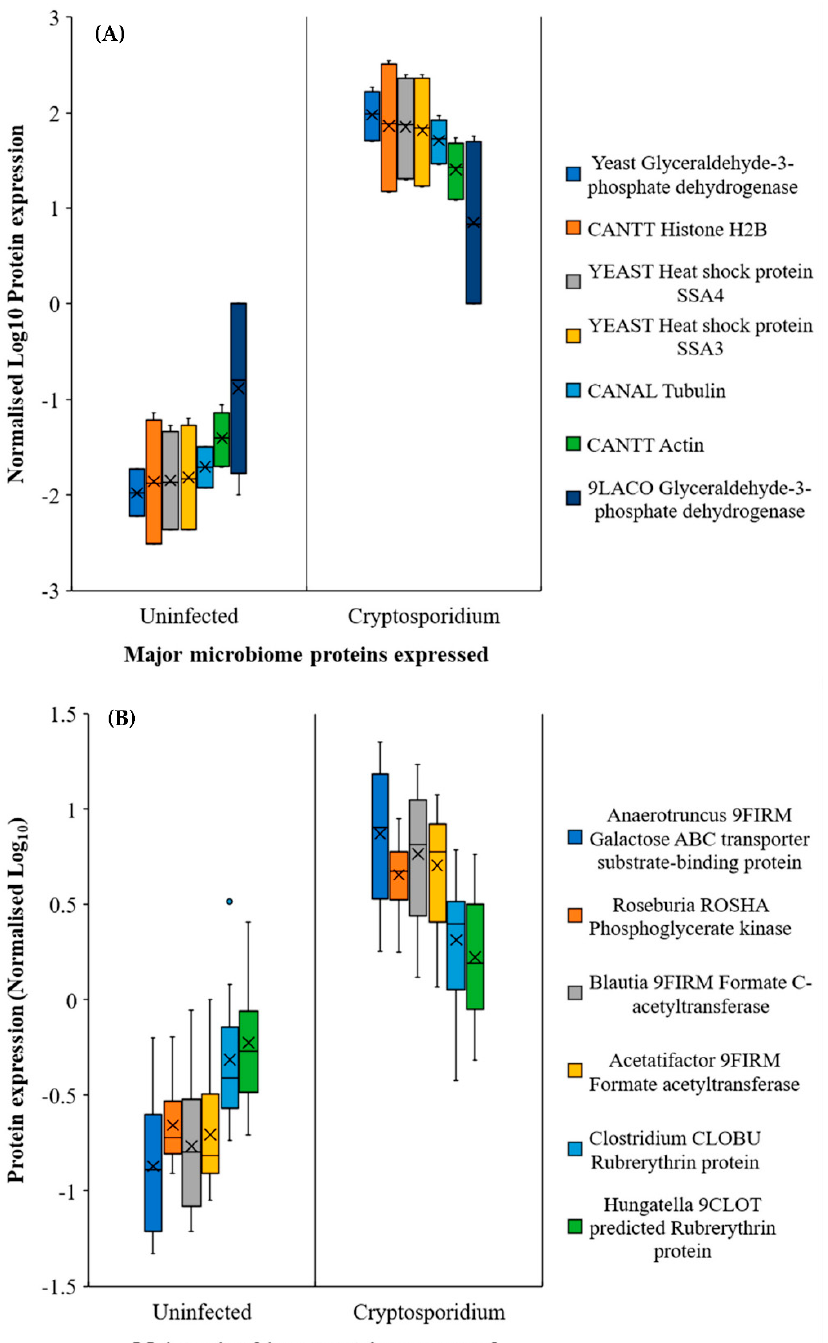
Figure 5. Major proteins expressed by microbial community in response to cryptosporidiosis in ( A ) the jejunum–ileum and ( B ) the caecum–colon region. Note: Error bars represent standard deviation between the experimental replicates ( n = 10 for A and B ).